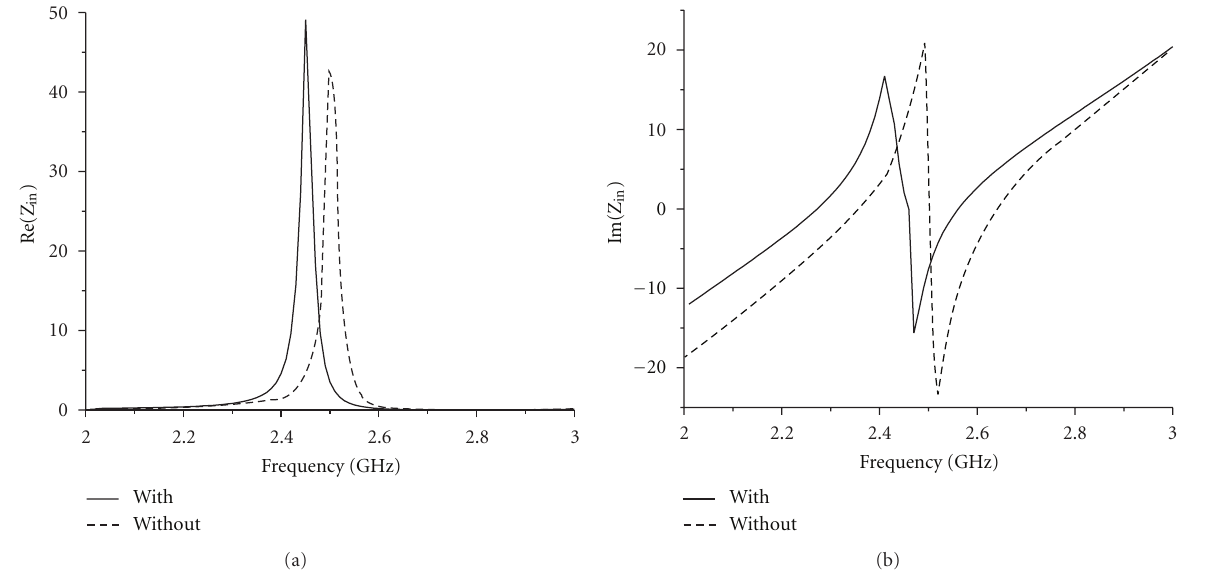
Figure 5: Input impedance comparison of the antenna with or without a trident-shaped feeding strip and 4 pairs of triangular slot stubs.